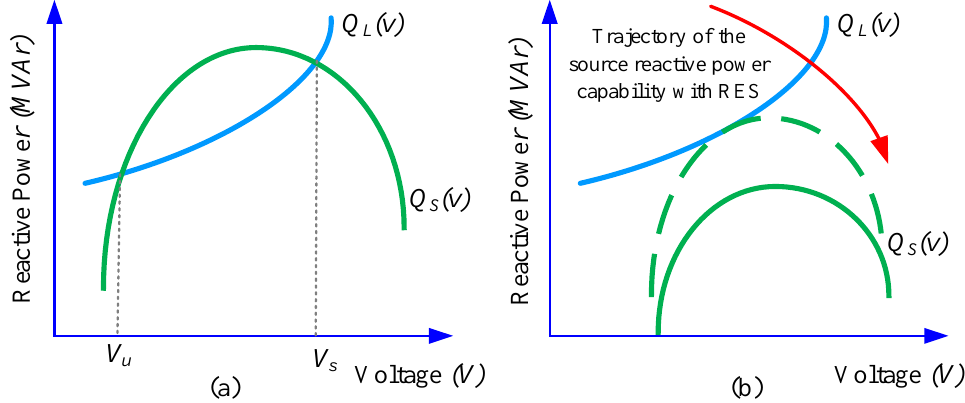
Figure 9. Representation of voltage stability as an equilibrium between source and load reactive power; ( a ) Stable case, ( b ) System moving towards voltage instability.